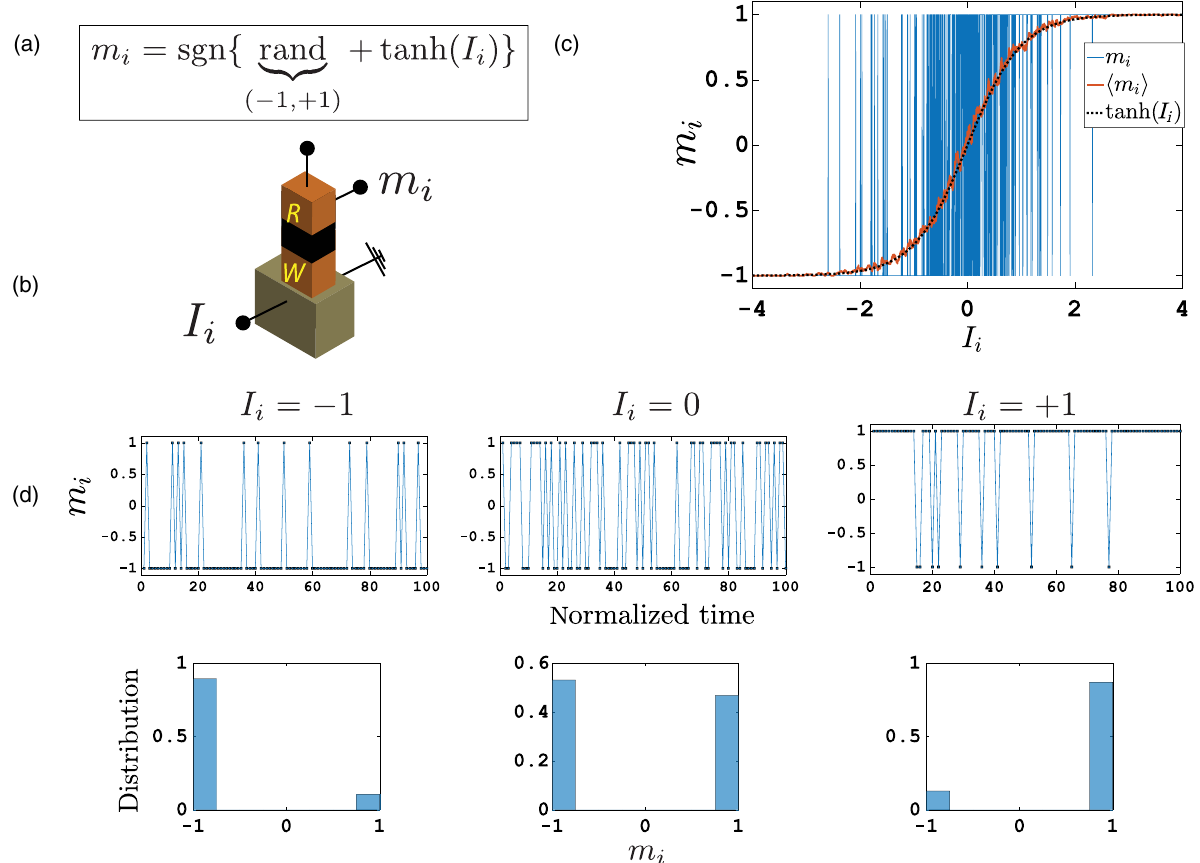
FIG. 1. Generic building block for PSL. (a) Generic model for PSL described by Eq. (1) with distinct READ and WRITE units represented by the R and W icon shown in (b). Useful functionalities are obtained by interconnecting R and W units according to Eq. (2), P I I h J m h g and [ J ]. (c) The blue trace shows the “ magnetization ” ( m i ¼ 0 ð i þ ij j Þ , with appropriately designed f Eq. (1) as the current ( I i ) is ramped. The red trace shows the sigmoid response obtained from a RC circuit which provides a moving average of the time-dependent “ magnetization ” that agrees very well with the black curve showing tanh ð I i Þ . The bias terminal could involve a voltage ( V ) instead of a current ( I ), just as the output could involve quantities other than magnetization. (d) The idealized telegraphic behavior of the model is shown at various bias points along with corresponding